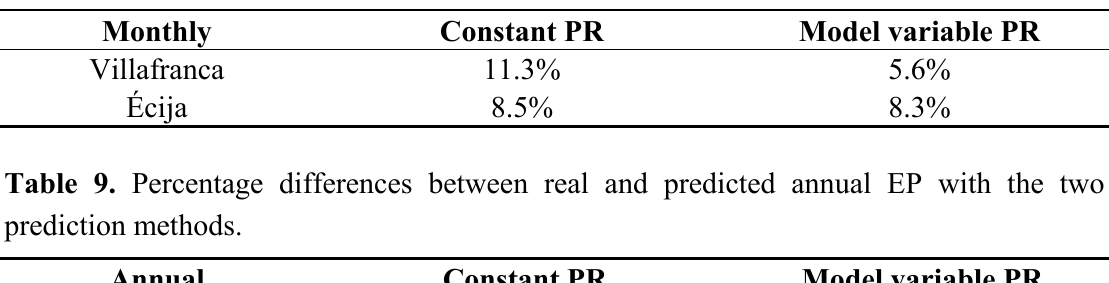
Table 8. Percentage differences between real and predicted monthly EP with the two prediction methods.